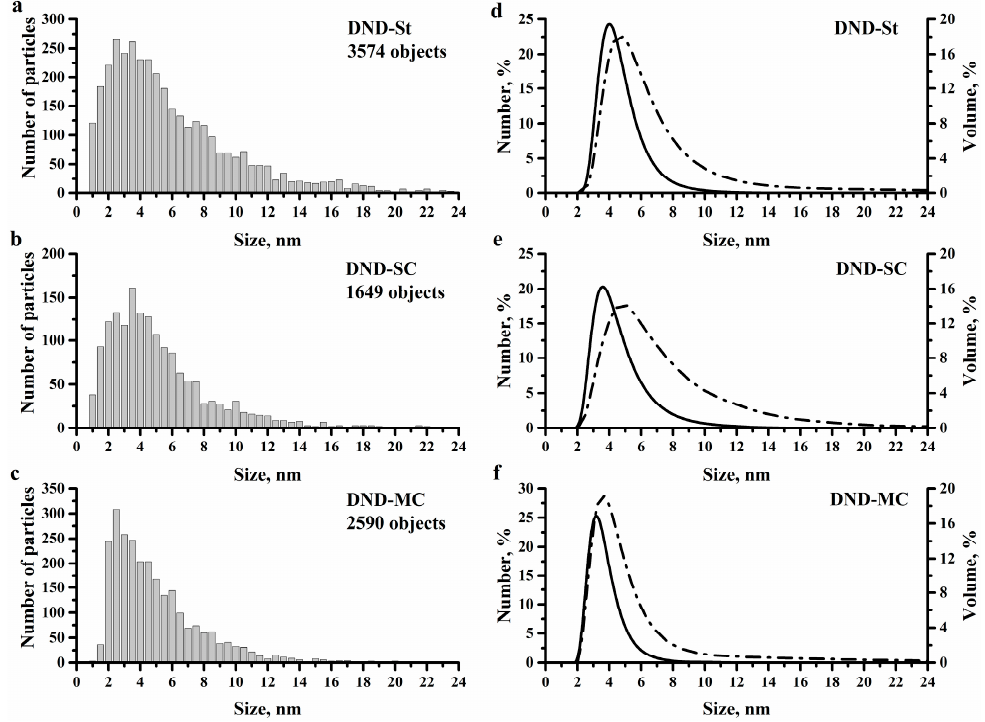
Figure 2. Particle size distributions obtained using the AFM ( a – c ) and DLS ( d – f ) methods for investigated samples. The DLS particle size distributions by number are represented by a solid line, while distributions by volume are represented by the dash dot lines.